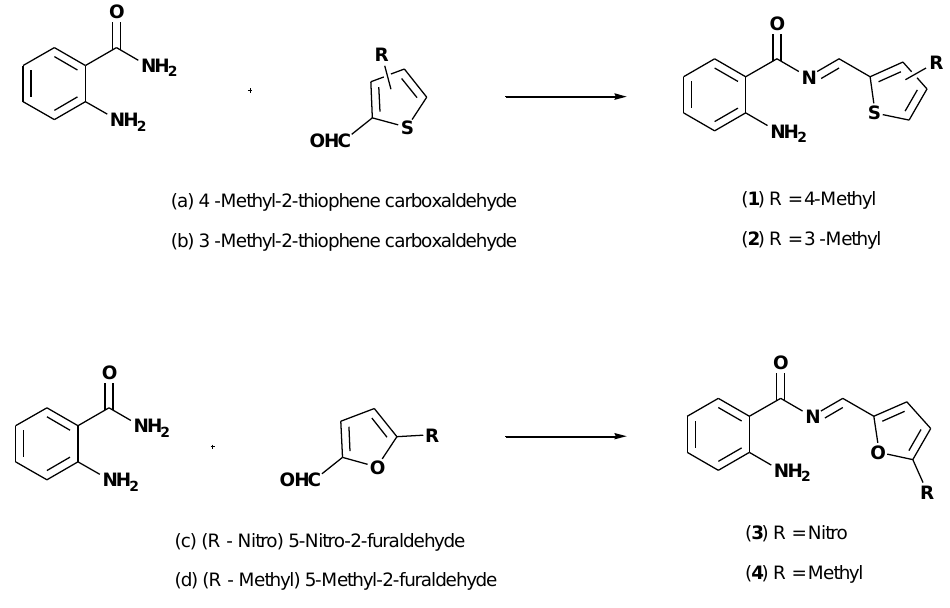
Figure 1. The structures of Schiff base compounds.